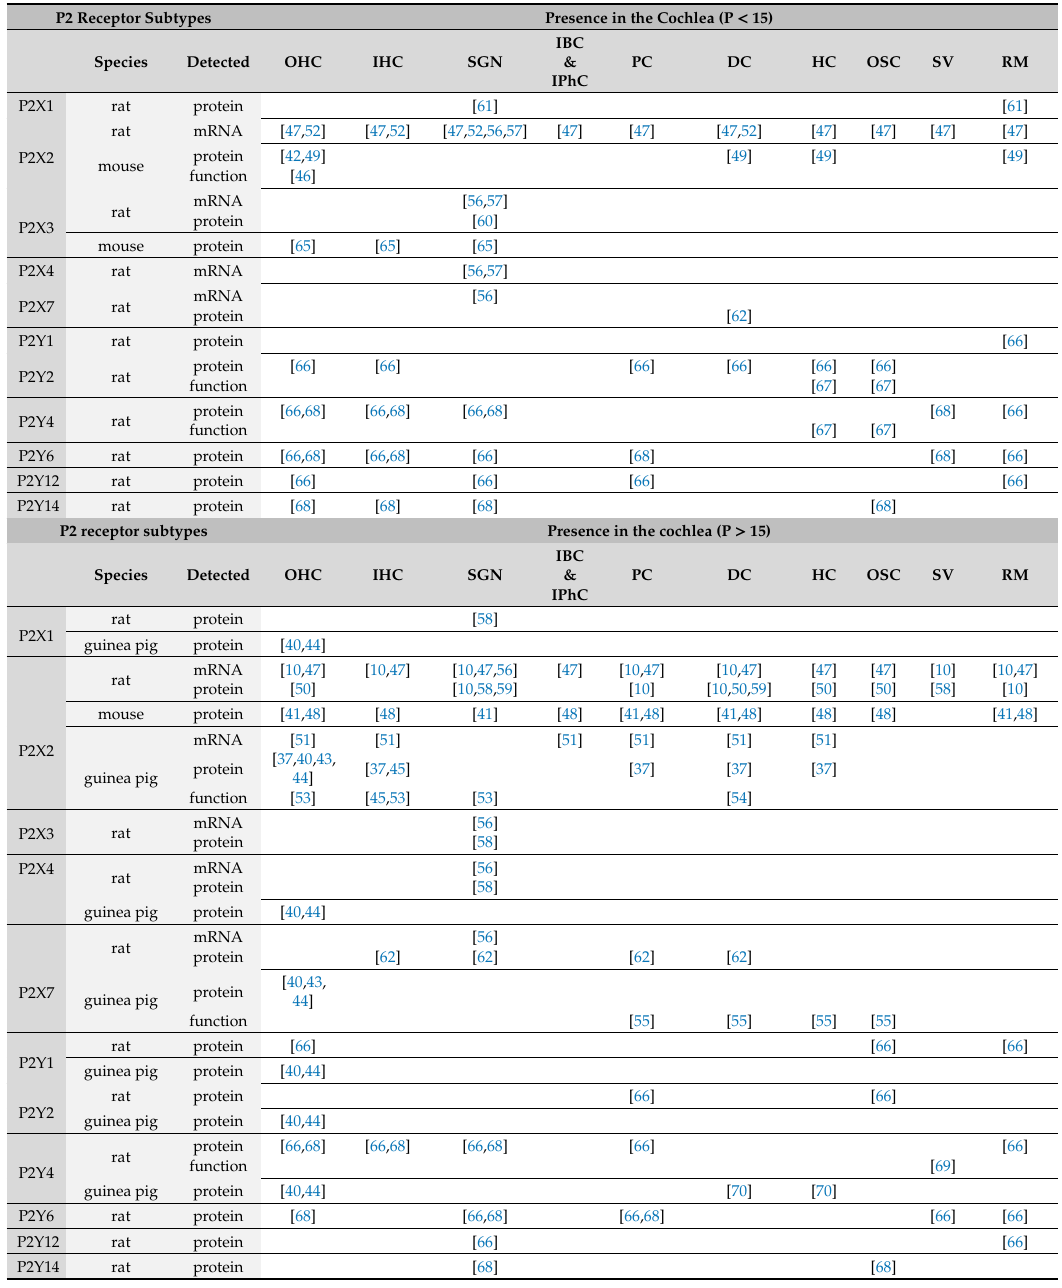
Table 1. Expression of P2 purinergic receptors in the cochlea before and after hearing onset (P15) in rodents. It includes only subtype and cell specific results. mRNA detection means PCR analysis and in situ hybridization, protein detection means Western-blot analysis and immunohistochemistry, while functional detection indicates pharmacological analysis in electrophysiological or Ca 2 + imaging experiments. Results from guinea pigs are not separated by age as these animals have in utero hearing. These data are shown in the second part (P > 15) of the table. IHC: Inner hair cell; OHC: Outer hair